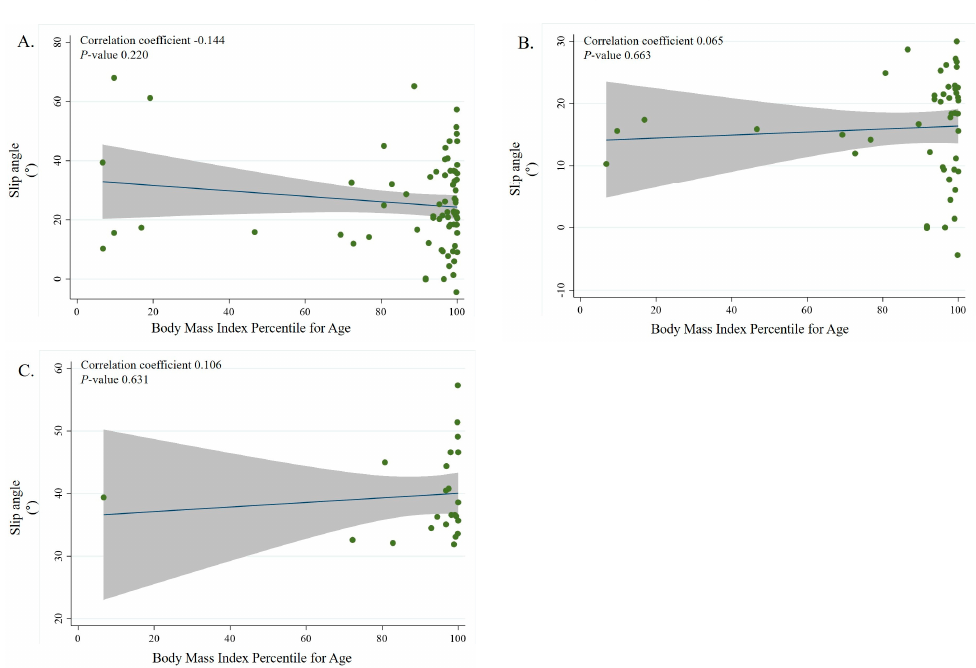
Figure 2. Scatterplots showing the relationship between slip angle represented by the Southwick angle difference in SCFE and BMI percentile for age. In the figure, the blue color line is the linear prediction plot and the gray zone means the 95% confidence interval. Subgroup correlation between BMI percentile for age and slip severity overall (correlation coefficient = − 0.144, p < 0.220) ( A ), for mild slip severity (correlation coefficient = 0.065, p < 0.663) ( B ), and moderate slip severity (correlation coefficient = 0.106, p < 0.631) ( C ). We performed univariate analysis to find any variables affecting slip severity (Table 3). However, no variable was found to significantly affect slip severity in univariate analysis. Table 3. Univariate analysis a ff ecting slip severity.